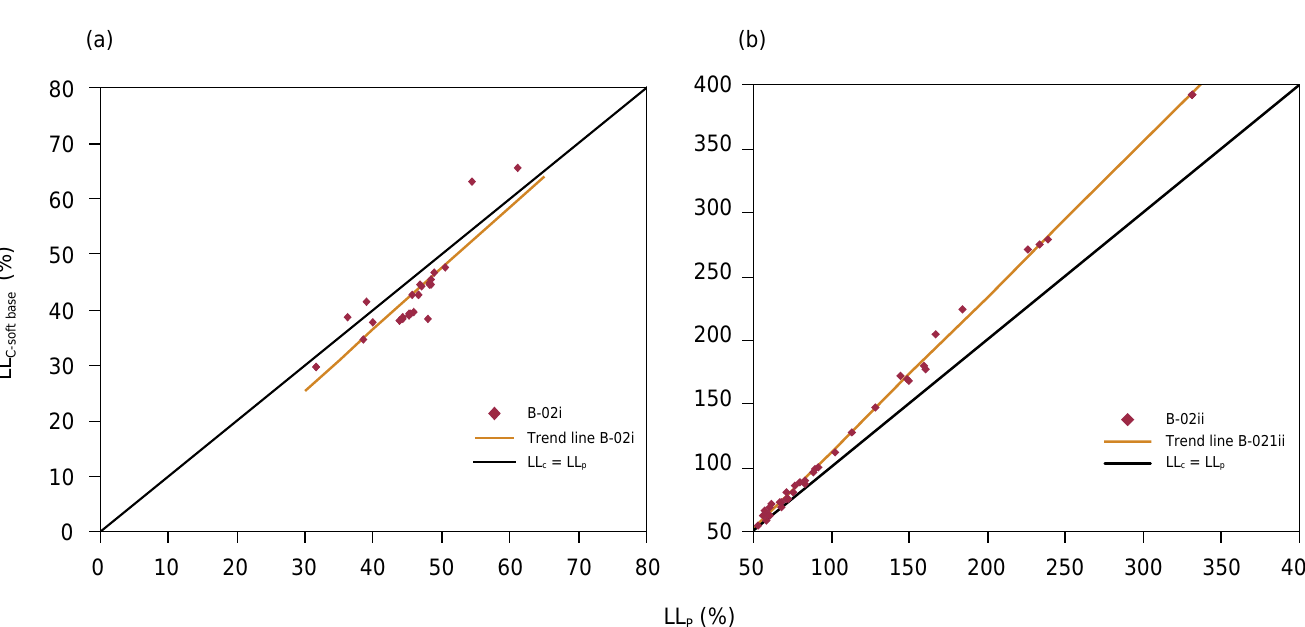
Figure 7. Trend lines of the experimental results, LL p -LL c-soft base , of the soils investigated in group B-02: subgroups B-02i (kaolinites and ilites) with 30< LL c <50 % (a); and subgroups B-02ii (smectites) with 50< LL c <400 %